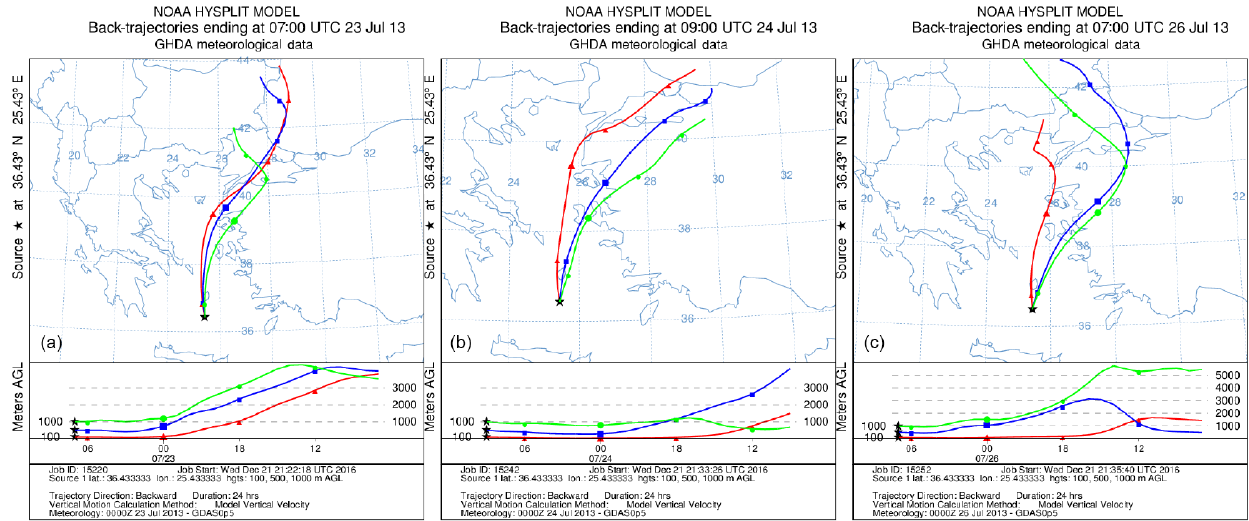
Figure 2. HYSPLIT4 back-trajectories computed with an end point at the Santorini station (from the heights of 100, 500, and 1000m), on 23 (left panel), 24 (central panel) (both during EF period), and 26 July (MSF – right panel) 2013. Table 2. Average ( ± standard deviation) of O 3 concentrations and aerosol mass and number concentrations during the two examined periods; (a) EF (22–24 July) and (b) MSF (25–27 July). Tracer Santorini Finokalia Santorini Finokalia EF period MSF